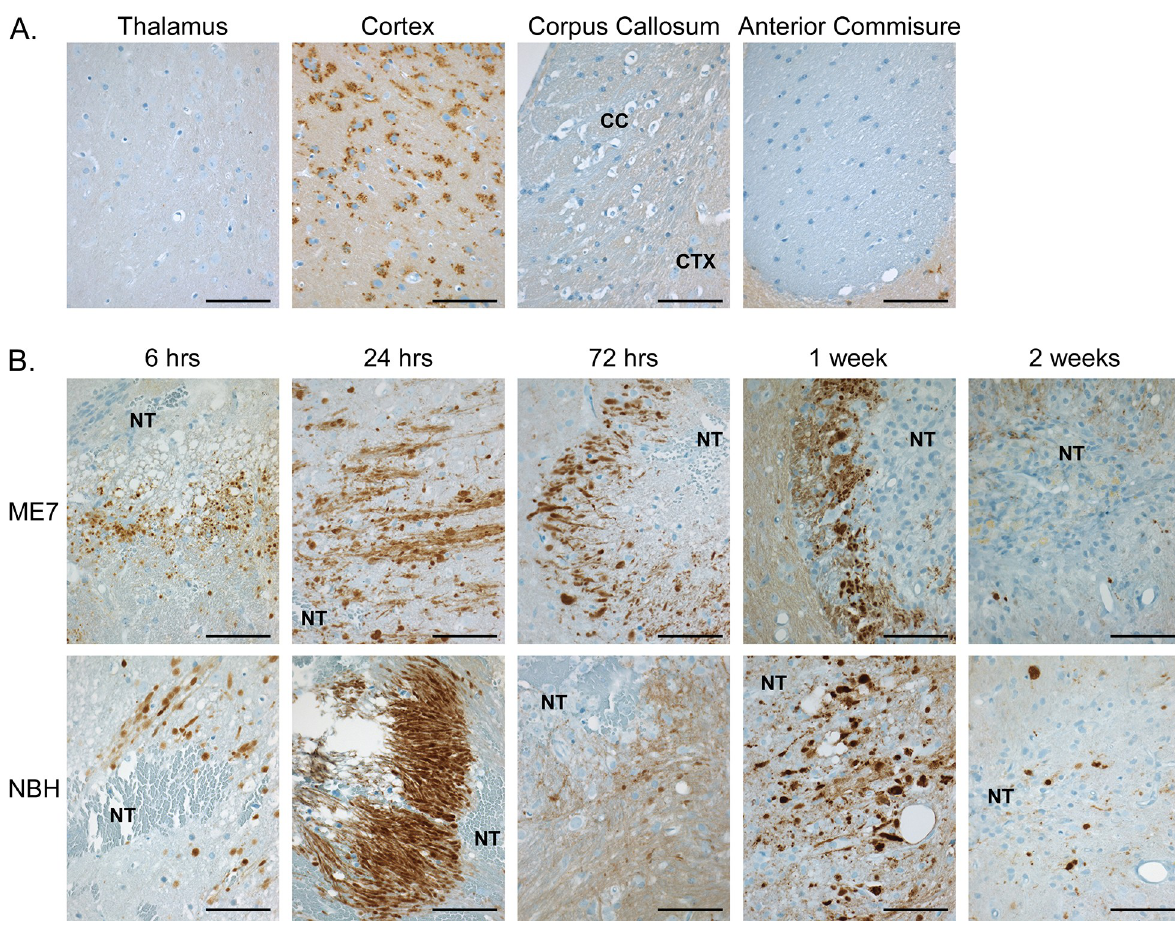
Fig 2. Endogenous PrP-3F4 staining in Tg3F4 mice following inoculation with ME7 prions or NBH. (A) PrP-3F4 staining in different brain regions of uninoculated Tg3F4 mice. (B) PrP-3F4 staining at different timepoints following the inoculation of mouse brain homogenate from mice infected with the ME7 strain of mouse prions (upper row) or inoculated with normal mouse brain homogenate (NBH, lower row). All sections are from the thalamus except for the ME7 6 hr timepoint (cortex/corpus callosum), the NBH 24 hr timepoint (fornix), and the ME7 2 week timepoint (hypothalamus). Sections were stained using the anti-PrP mouse monoclonal antibody 3F4 conjugated to biotin as detailed in the Materials and Methods. The sections shown are representative of the 4 animals analyzed at each timepoint. CC = corpus callosum; CTX = cortex; NT = needle track. Scale bar = 50 μ